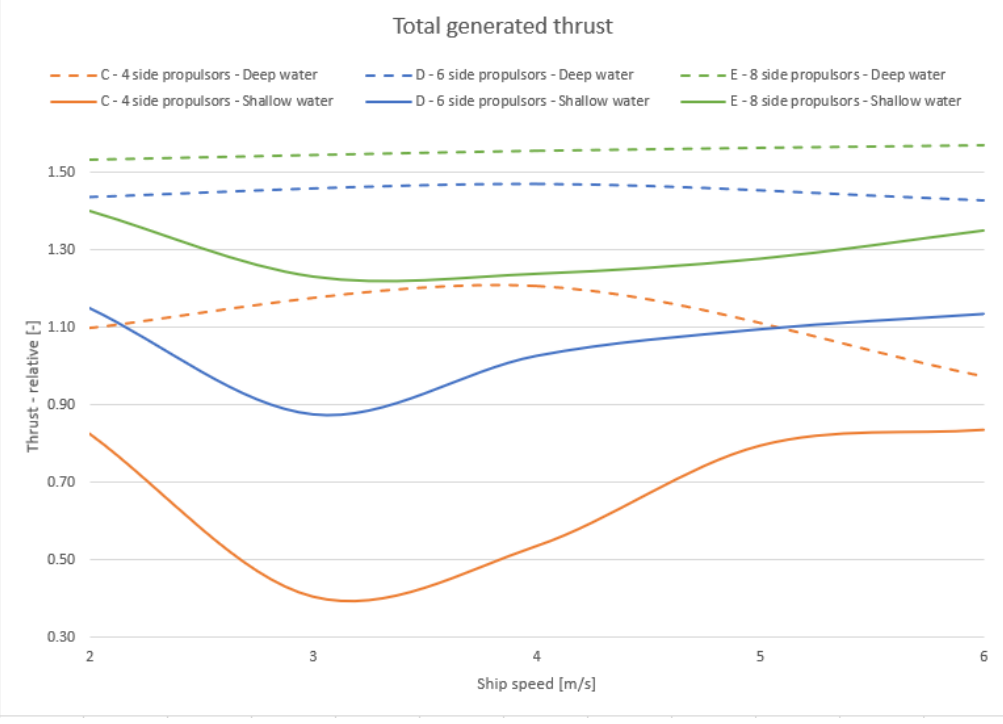
Figure 15. Thrust of distributed systems in deep and shallow water conditions. Source: Authors.